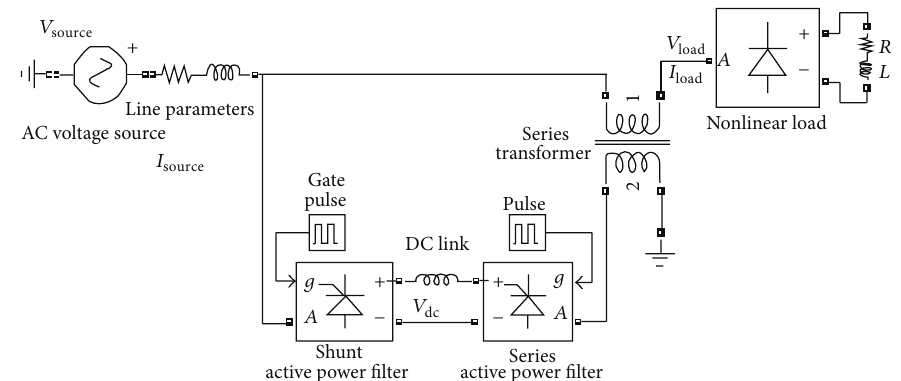
Figure 1: The design configuration of